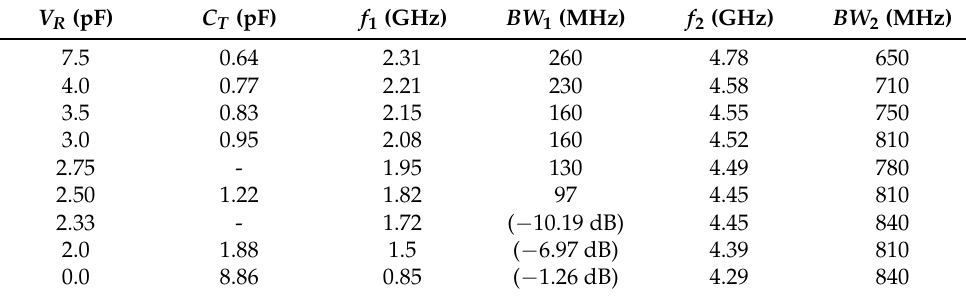
Table 7. Measurement—stop band center frequency and bandwidth